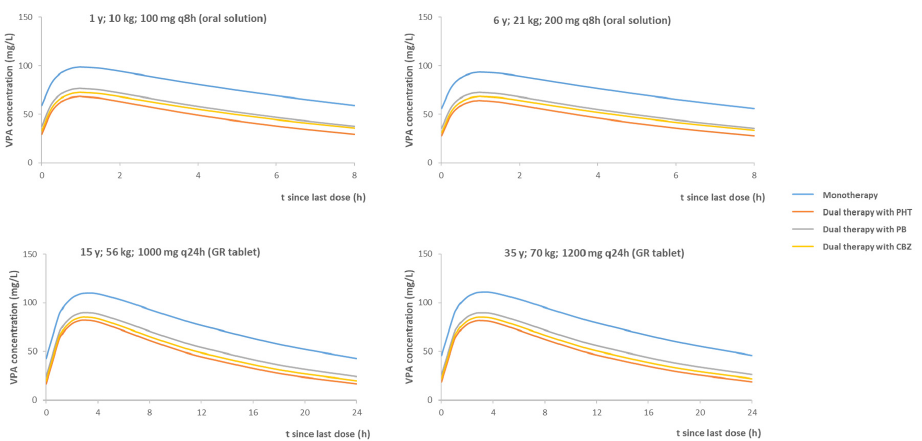
Figure 2. Valproic acid (VPA) concentration–time profiles simulated with the final model devel- oped. The following acronyms represent the drug administered in each scenario: VPA monotherapy together with carbamazepine (CBZ), phenobarbital (PB) and phenytoin (PHT); GR: